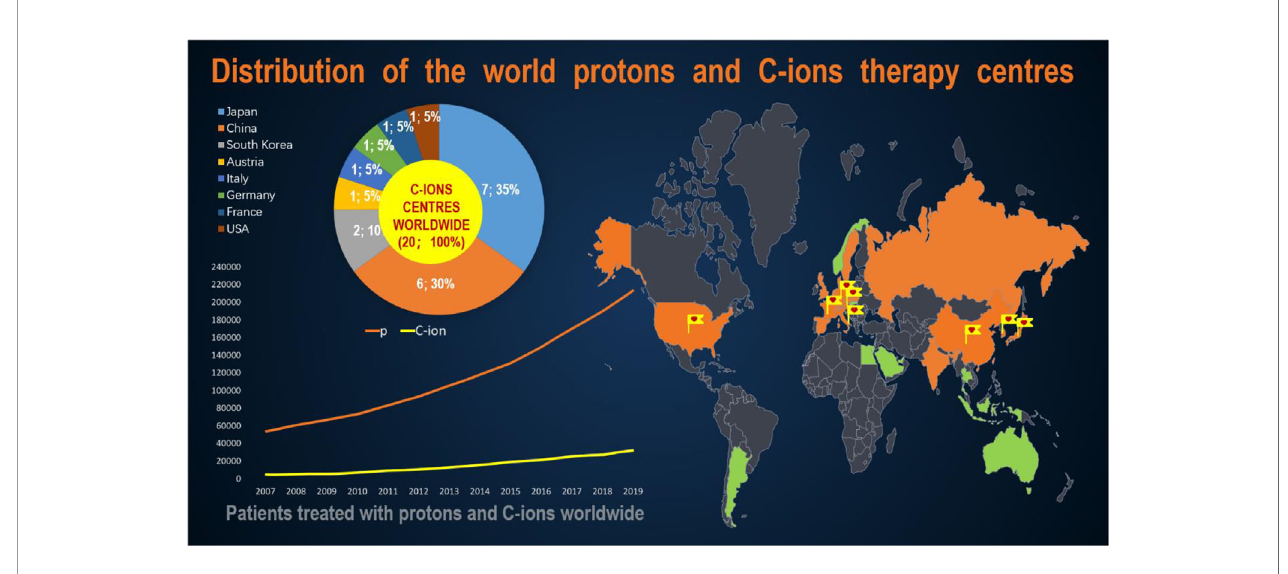
FIGURE 2 | Distribution of the world protons and C-ions therapy